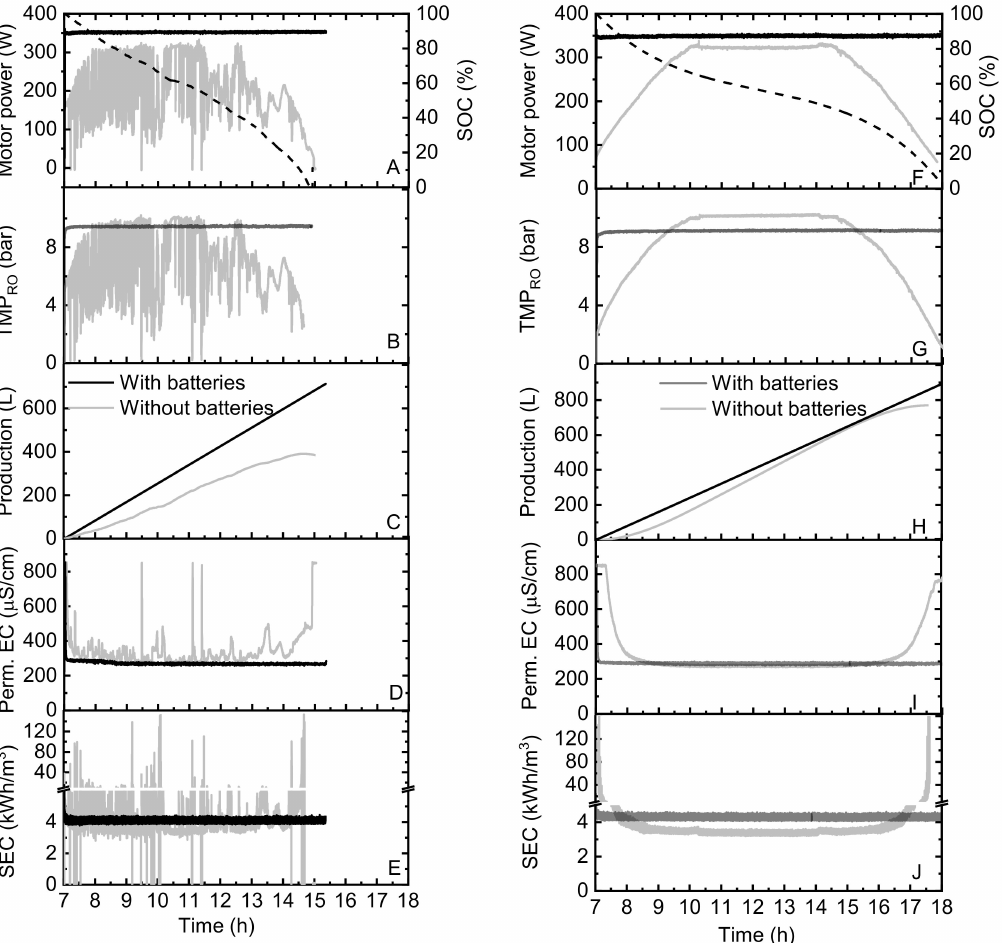
Figure 4. Cumulative performance of the PV-membrane system with/without (grey curves) fully charged battery storage (100% initial SOC, black curves) on the “very cloudy day” (left graph) and “sunny day” (right graph) in terms of ( A , F ) the motor power and SOC, ( B , G ) TMP RO , ( C , H ) production, ( D , I ) permeated EC and ( E , J )